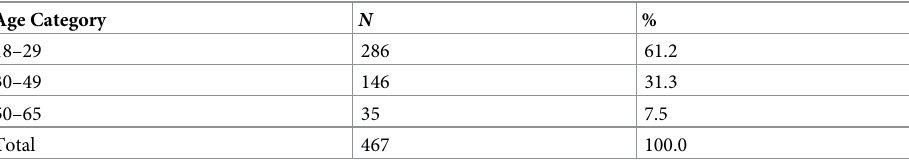
Table 1. Frequency distribution by age category (n = 467).